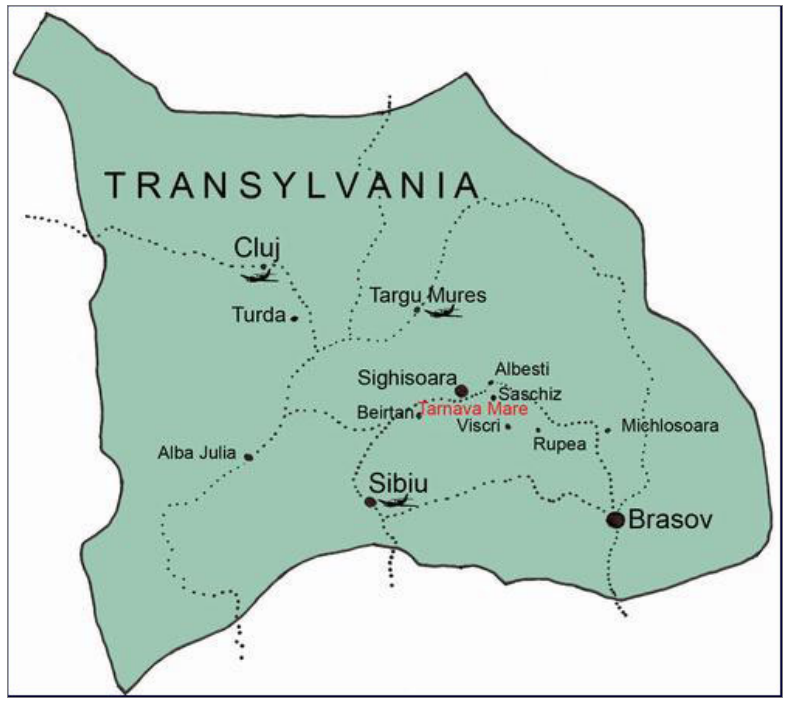
Figure 1: Location of the Târnava Mare region within